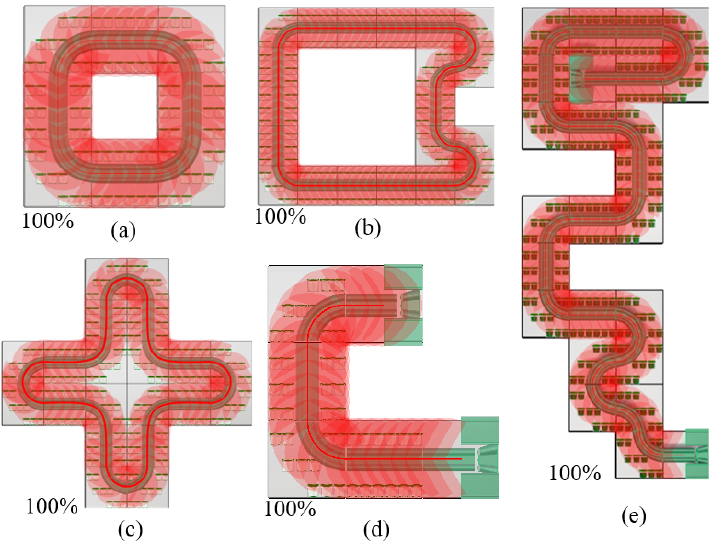
Figure 10. Robot reachability evaluation for vertical garden layouts that follow the proposed design guidelines. The track height is 10 cm for all the cases. The robot reachability of each case is overlaid in shaded color. The resultant percentage pot reachability is given under each case. ( a – c ): closed track designs. ( d , e ): open track designs. It should be noted that the figures are not in the same scale.